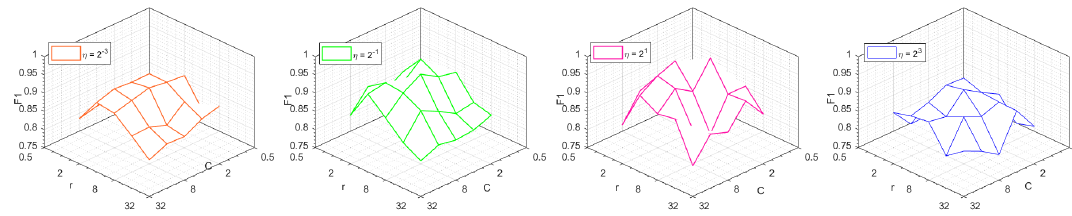
Figure 6. Detection accuracy ( F 1) on the verification set using different r , C , and η